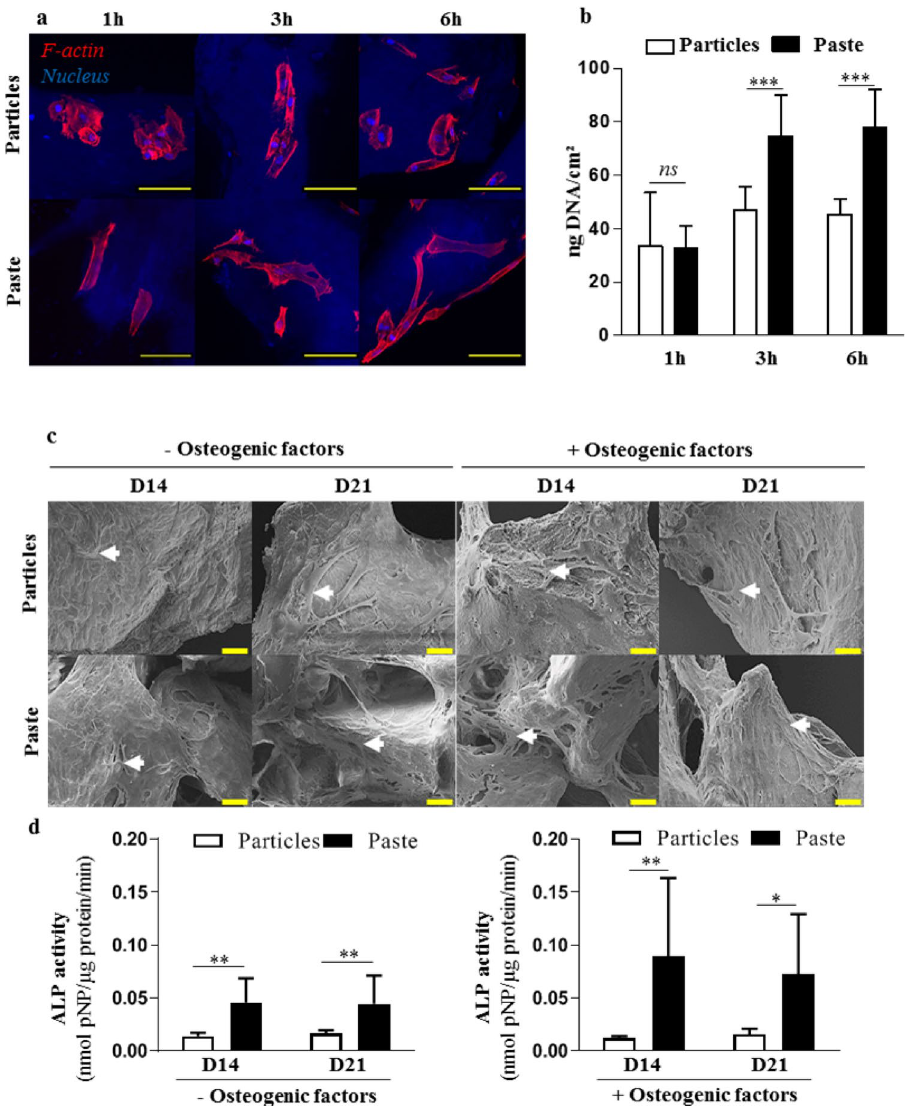
Figure 1. Attachment and osteoblastic commitment of hBM-MSCs cultured in contact with the particular bone graft or the bone paste. ( a ) Representative confocal images of stained hBM-MSCs. Red (phalloidin-AF568): F-actin, blue (Hoechst): nucleus. The particular bone graft and the bone paste were visible as a result of their blue auto fluorescence. Scale bars: 100 µm. ( b ) Quantification of the total DNA in hBM-MSCs in contact with the particular bone graft or the bone paste. ( c , d ) SEM images and ALP activity in lysates of hBM-MSCs grown in contact with the particular bone graft or bone paste with or without osteogenic factors for 14 and 21 days. Scale bars: 20 µm. The results are expressed as means ± the SD (N = 3, n = 3; * p < 0.05, ** p < 0.01 *** p <